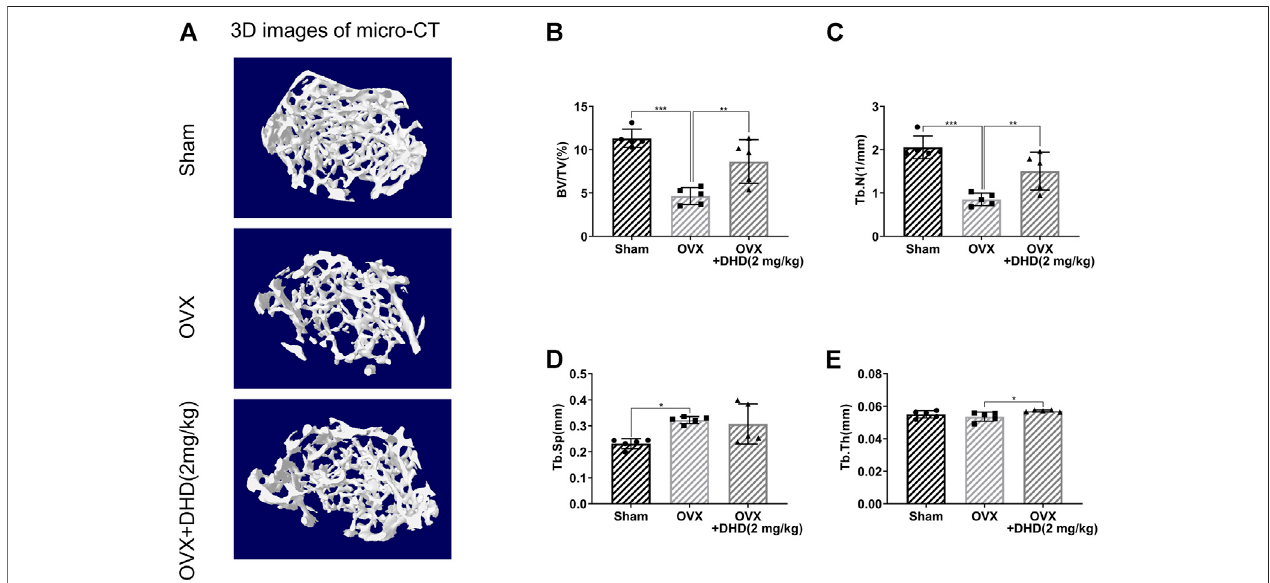
FIGURE 10 | DHD ameliorates OVX-induced systemic bone loss in vivo . (A) Representative 3D reconstruction micro-CT images of femur trabecular bone in the Sham, OVX, and OVX + DHD (2 mg/kg) groups. (B – E) BV/TV, Tb.N, Tb.Sp, and Tb.Th were quantitatively analyzed based on micro-CT results.